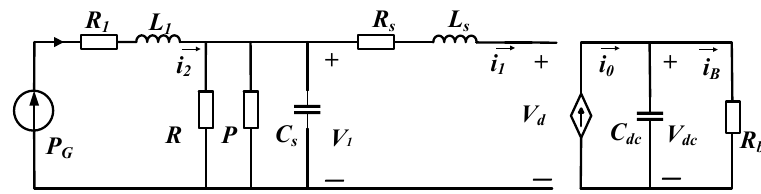
Figure 7. Nonlinear model of AC microgrid in charging state.